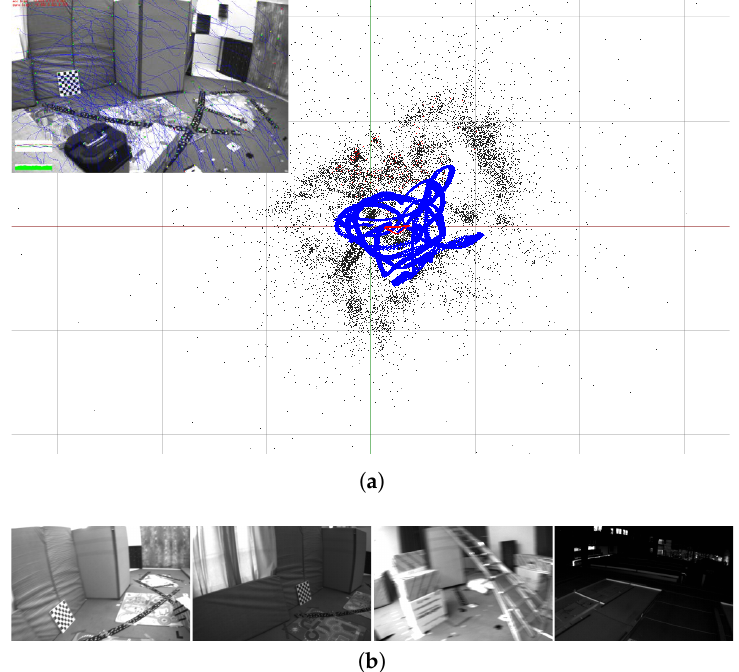
Figure 2. ( a ) An example result of the proposed system for V1-02 of the EuRoCbenchmark dataset. The blue line is the estimated trajectory; the black dots are the reconstructed sparse landmarks; and the red quadrangular pyramid represents the current camera pose. ( b ) Captured images in EuRoC with various challenges, such as motion blur and illumination changes. Our proposed system is able to estimate reliable poses for all sequences of EuRoC datasets (Section